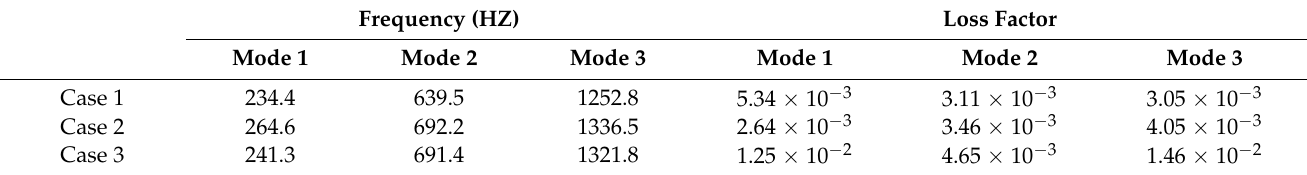
Table 5. Natural frequency and loss factor of pipeline in three cases.